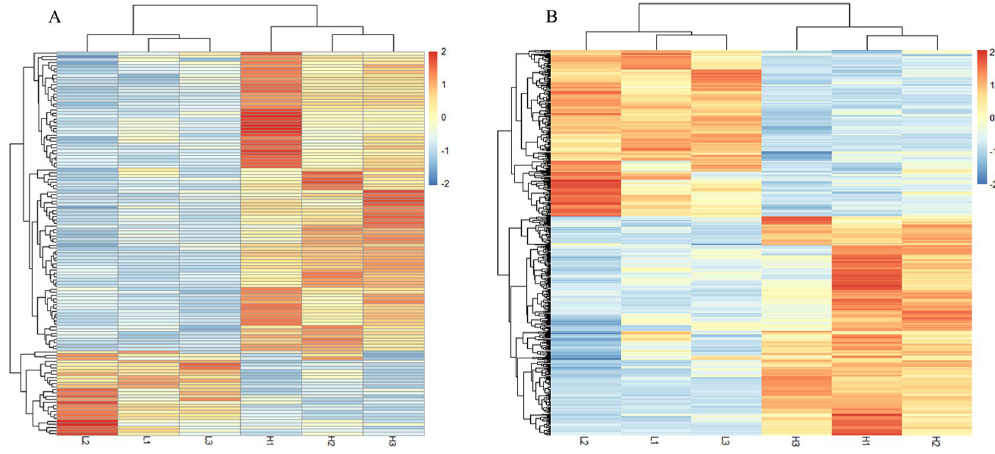
Figure 3. Heat maps of the distinguishable expression profiles in chicken testis between low and high sperm motility groups. ( A ) Hierarchical clustering of the differentially expressed lncRNA. ( B ) Hierarchical clustering of the differentially expressed mRNAs.